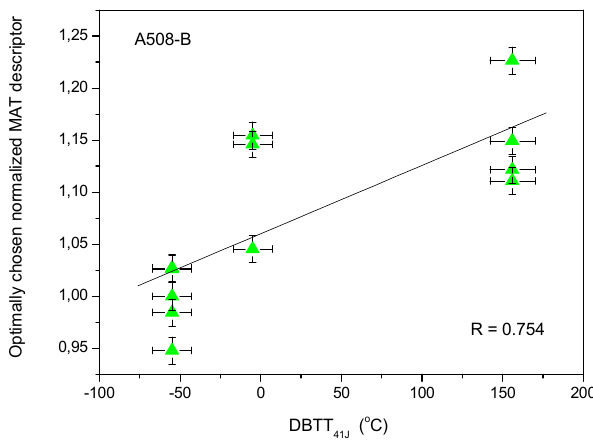
Figure 4. Optimally chosen magnetic adaptive testing (MAT) descriptor of reference and of irradiated A508-B type reactor steel base material as a function of transition temperature, ductile-to-brittle transition temperature (DBTT).